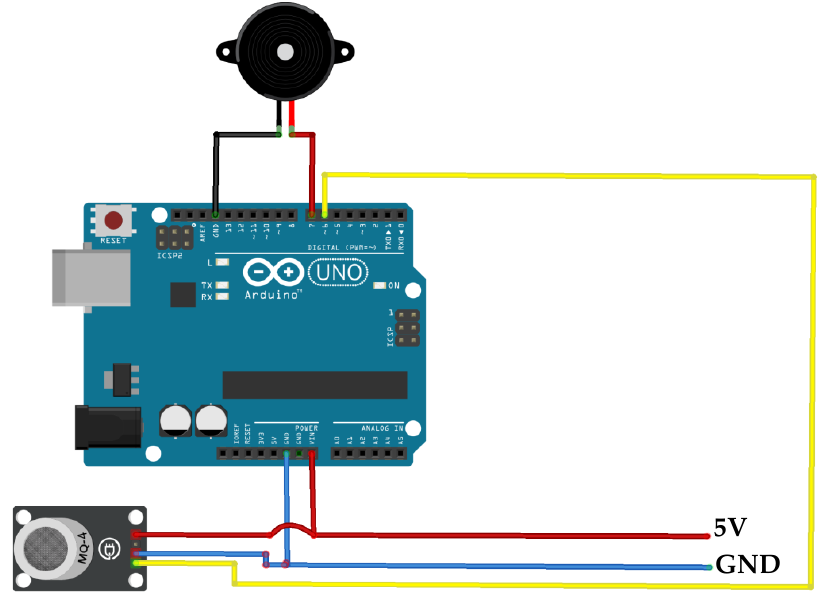
Figure 12. The control circuit for the toxic gas warning system in the smart home.